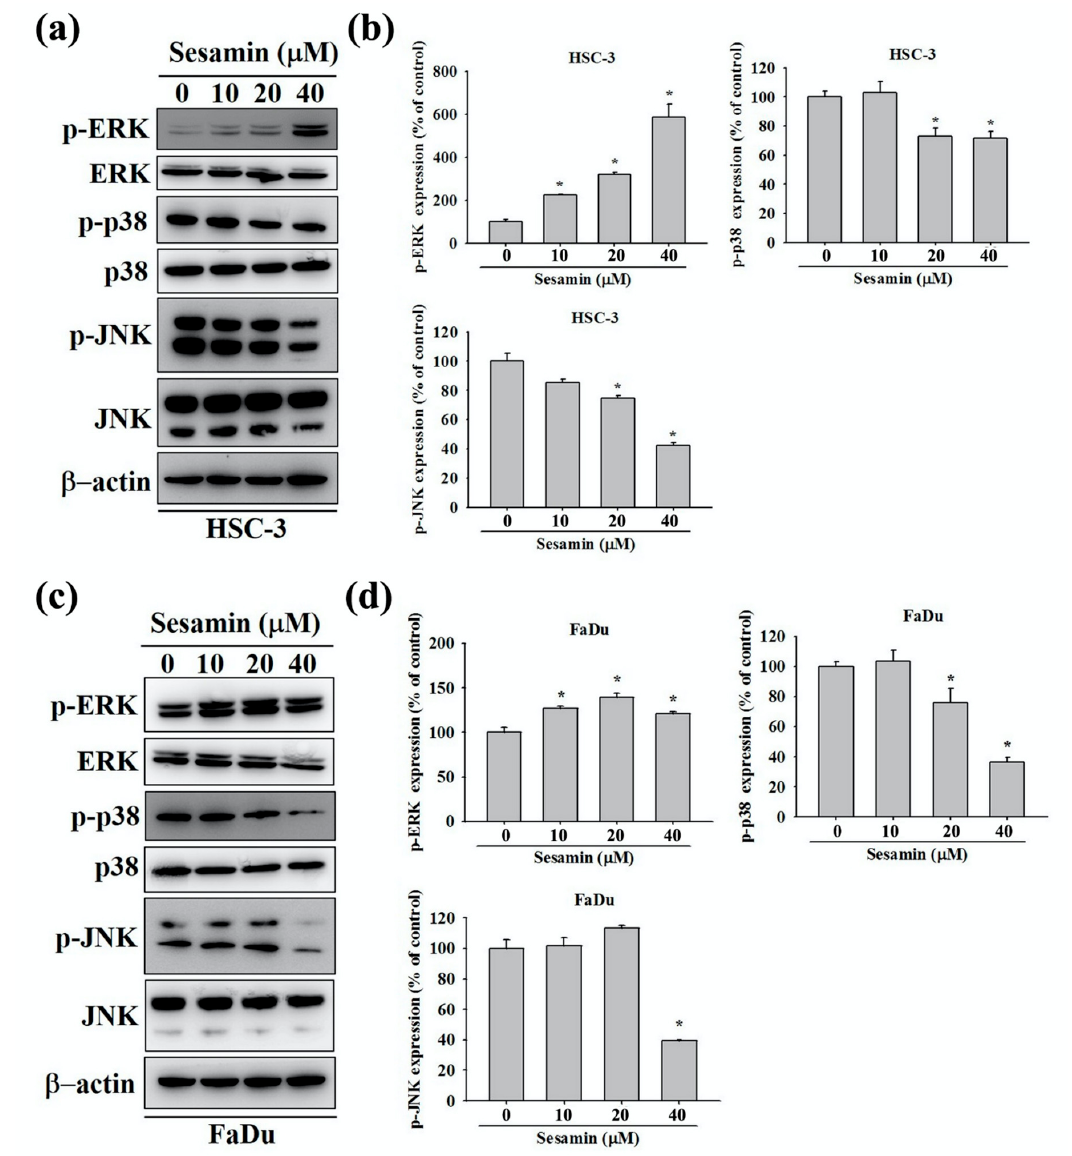
Figure 5. Mitogen-activated protein kinase activation in human oral cancer cells following sesamin treatment. ( a ) HSC-3 and ( c ) FaDu cells were treated with different concentration of SES (0, 10, 20, and 40 μ M), and the cell lysates were subjected to SDS-PAGE followed by Western blotting to detect the antibodies for phosphorylated ERK 1/2, p38, and JNK1/2. ( b ) and ( d ) show the quantitative results for the expression of each protein, after being adjusted to β -actin, in HSC-3 and FaDu cells. The values represent the means ± SD of at least three independent experiments. * p < 0.05, compared with the control group.